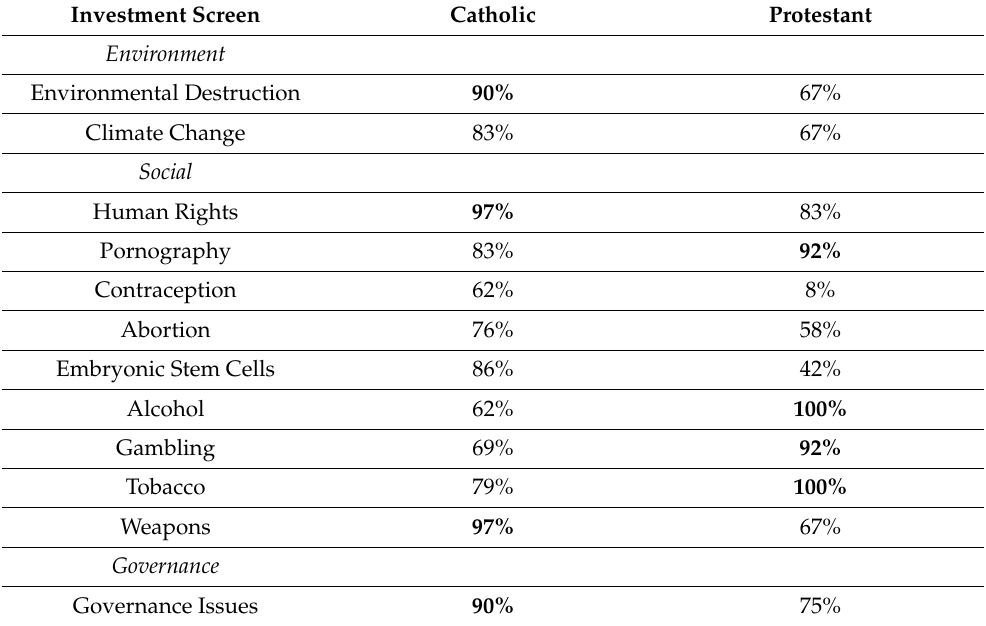
Table 4. Comparison of relevant topics of concern for Catholic and Protestant CIF